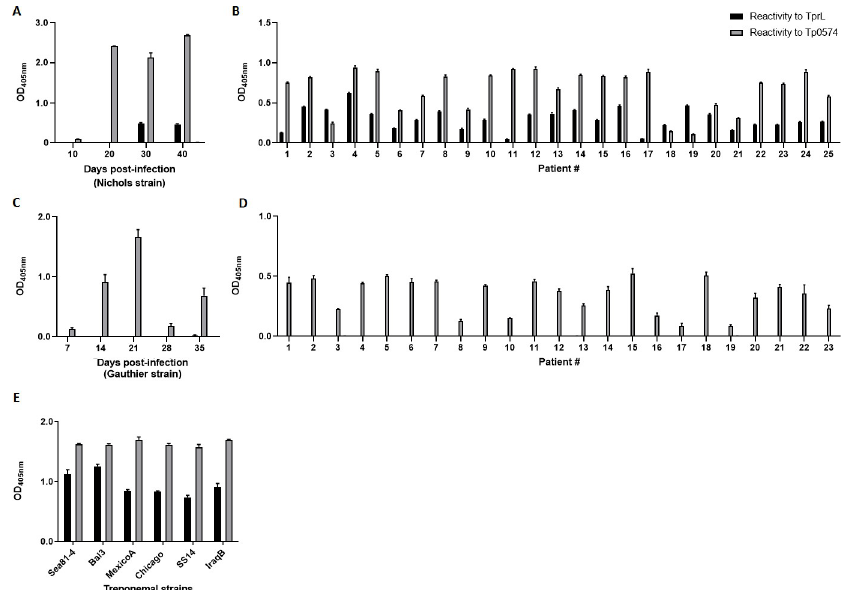
Fig 4. Humoral reactivity to TprL in experimental and clinical samples. ( A ) Pooled sera from rabbits (n = 2) infected with T . p . pallidum Nichols strain, and ( B ) individual sera from syphilis-infected patients. ( C ) Pooled sera from rabbits (n = 2) infected with T . p . pertenue Gauthier strain, and ( D ) individual sera from yaws-infected patients. Optical density from test sera in absence of target antigen was used for background subtraction. ( E ) Reactivity to TprL of sera obtained at day ~30 post-infection (from rabbits infected with T . p . pallidum strains (MexicoA, Chicago, SS14, Bal3, and Sea81-4), and T . p . endemicum (IraqB).